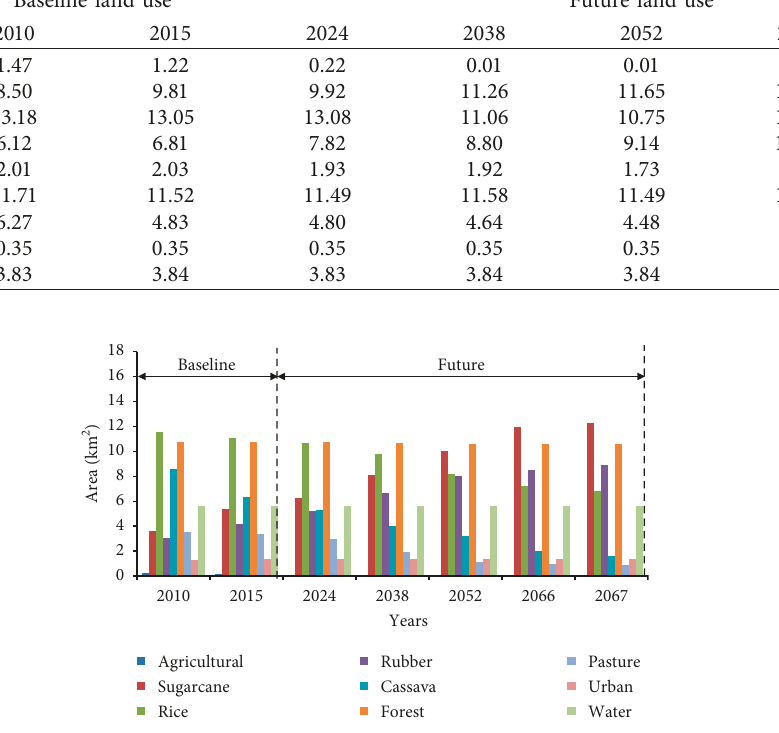
Figure 11: Historical and simulated land use areas above the Huay Sabag area by participation process.